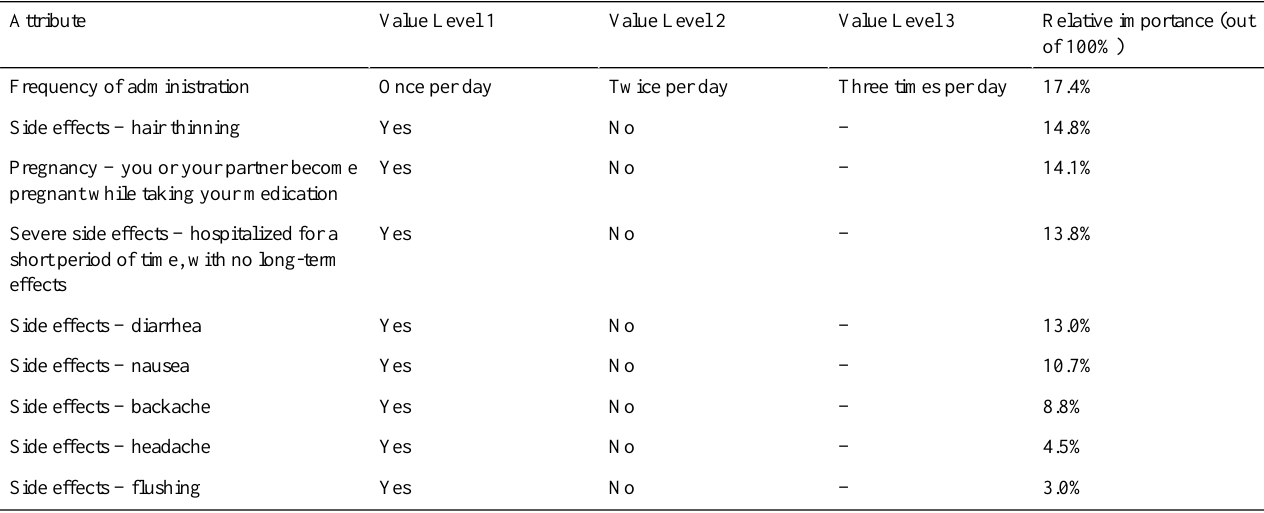
Table 2. Parameters and values for Conjoint Analysis Exercise 2 (CA2) ranked by order of importance to oral-naïve MS patients (n=319).